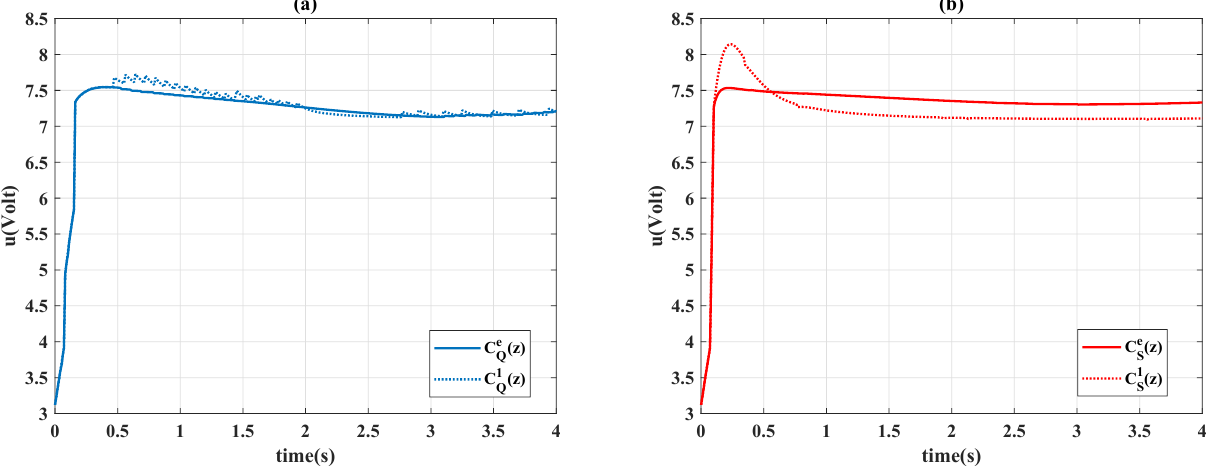
( z ) and C 1 ( z ) ; ( b ) Sarsa C Q Q Q